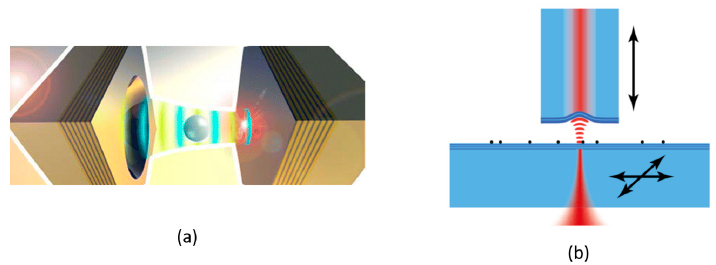
Figure 2. ( a ) Schematic representation of an open-access microcavity with a flat and a concave mirror. A nanoparticle in solution, trapped inside the optical mode is shown [51]; ( b ) Conceptual diagram of a laser-machined fiber with multilayer mirror on its end along with a flat mirror serving as a sample holder; black dots represent nanoparticles located on the flat mirror [52].